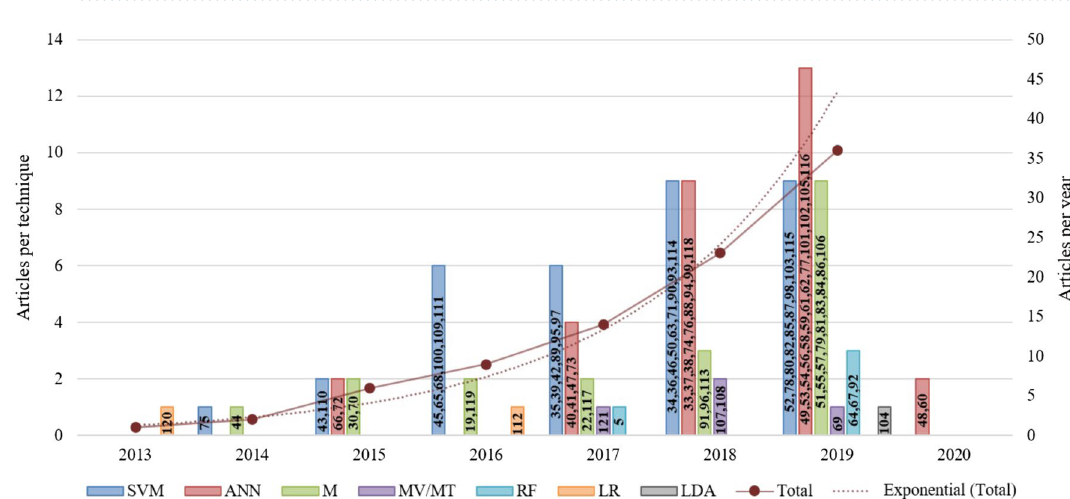
Figure 2. Distribution of the selected studies by year of publication and type of ML technique used ( MV/MT multiview/multitask learning, RF Random Forest, LR Logistic Regression; LDA Linear Discriminant Analysis). The numbers inside the bars indicate each article. Created with Microsoft Excel